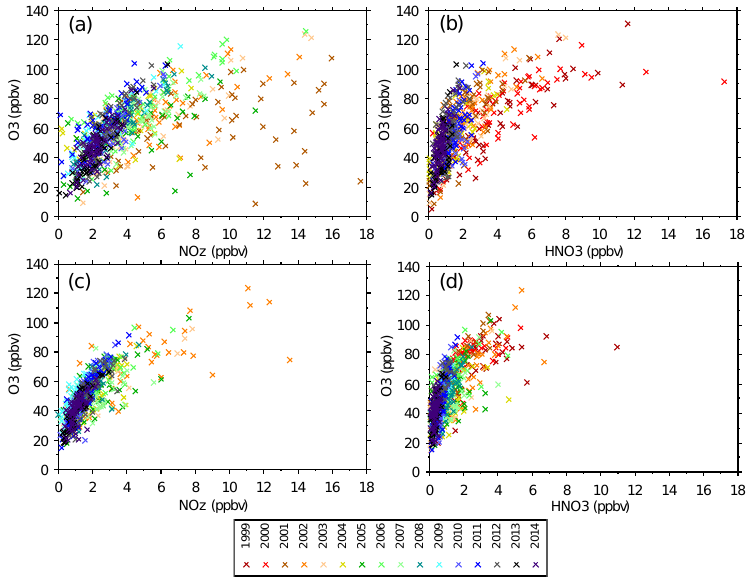
Figure 8. (a) O 3 vs. NO z at JST, (b) O 3 vs. HNO 3 at JST, (c) O 3 vs. NO z at YRK, and (d) O 3 vs. HNO 3 at YRK. Each point is the 14:00–15:00 hourly average on 1 day, limited to days in June or July and delineated by year. The 2001 and 2002 NO z data may be biased high due to lower NO 2 mixing ratios obtained by the instrumentation used at that time (Fig.